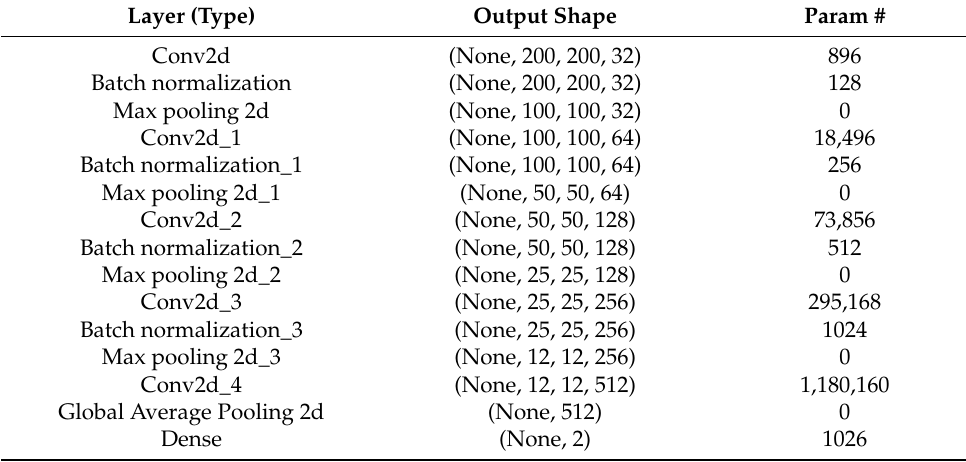
Table 1. CNN model